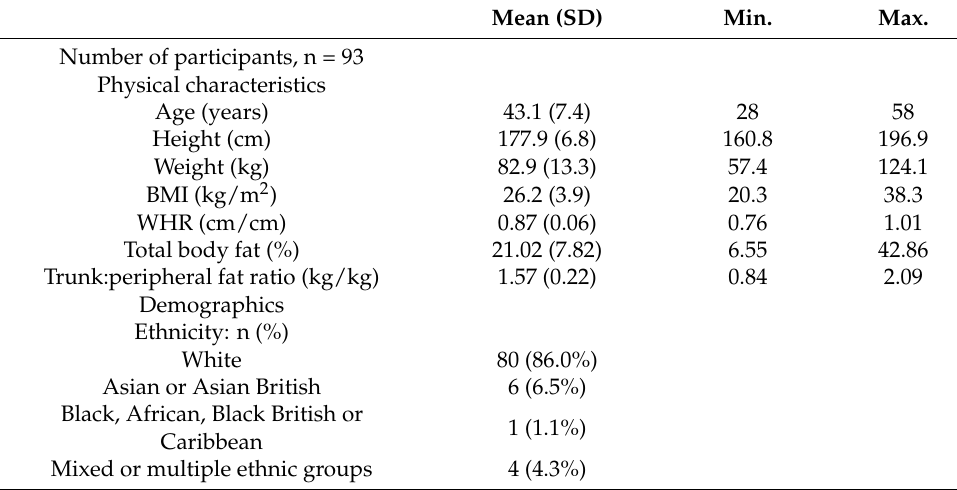
Table 1. Physical and demographic characteristics of